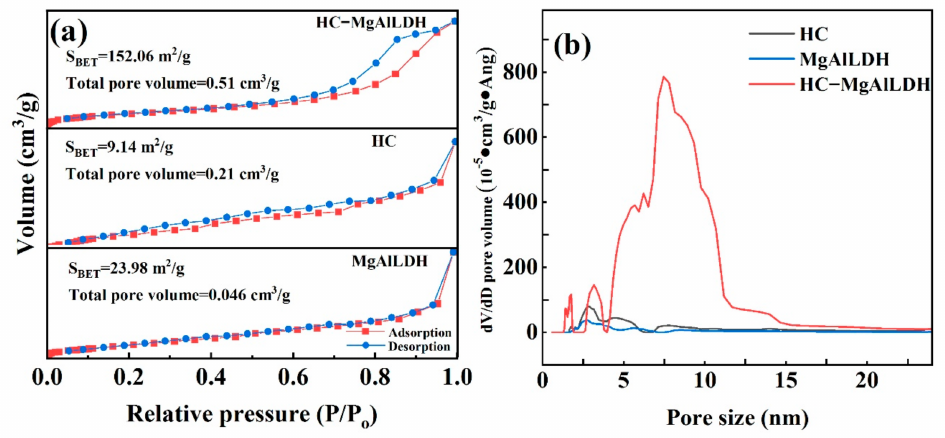
Figure 3. N 2 adsorption − desorption isotherms ( a ) and pore size distributions ( b ) of the MgAlLDH, HC and